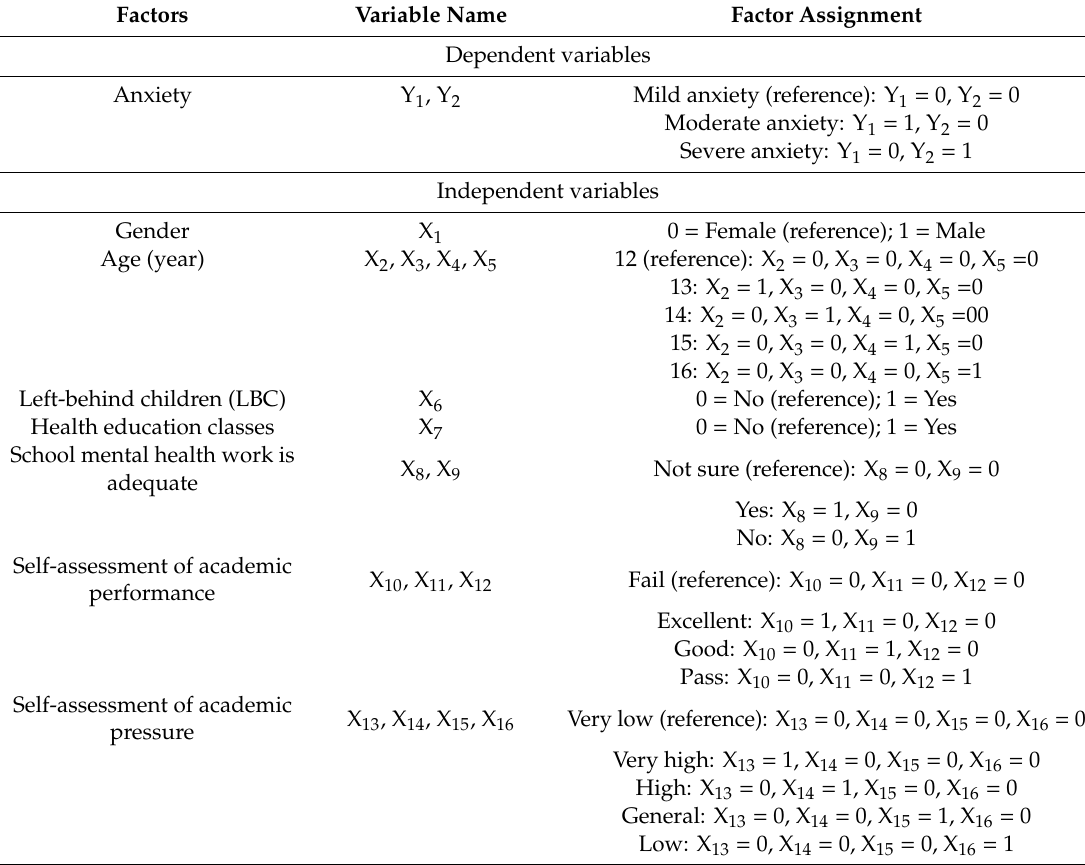
Table 3. The variable assignment summary for logistic regression